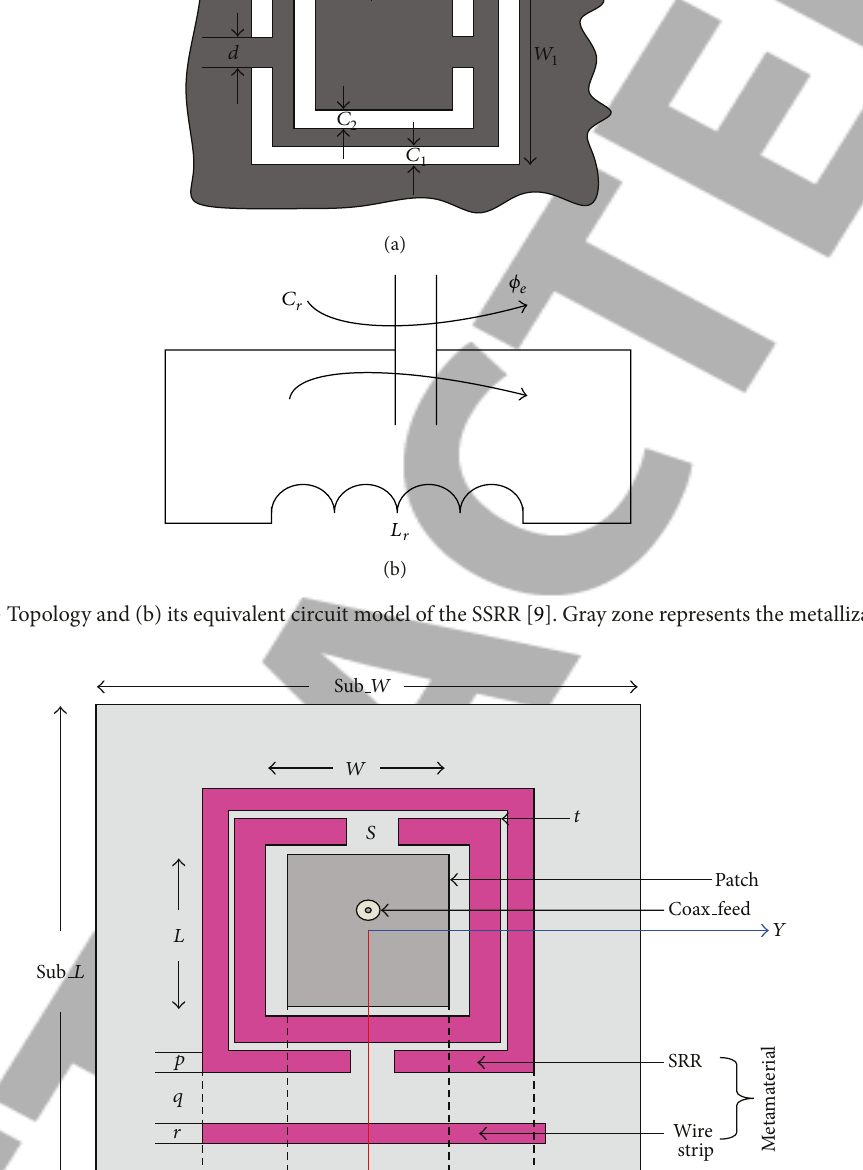
FR4 epoxy substrate and fed by a coaxial transmission